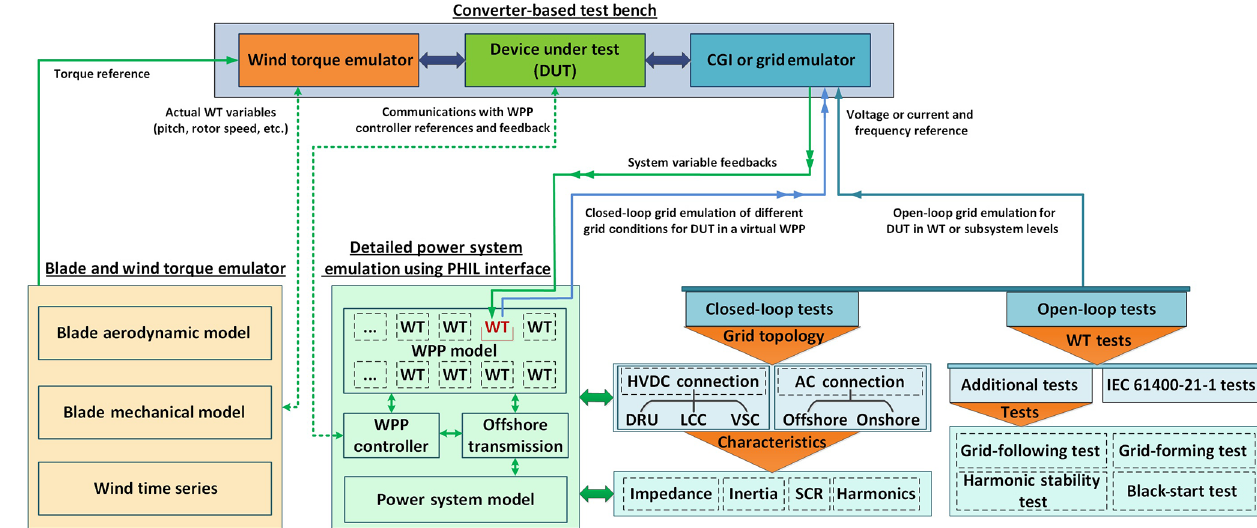
Figure 4. Proposed test structure for converter-based test